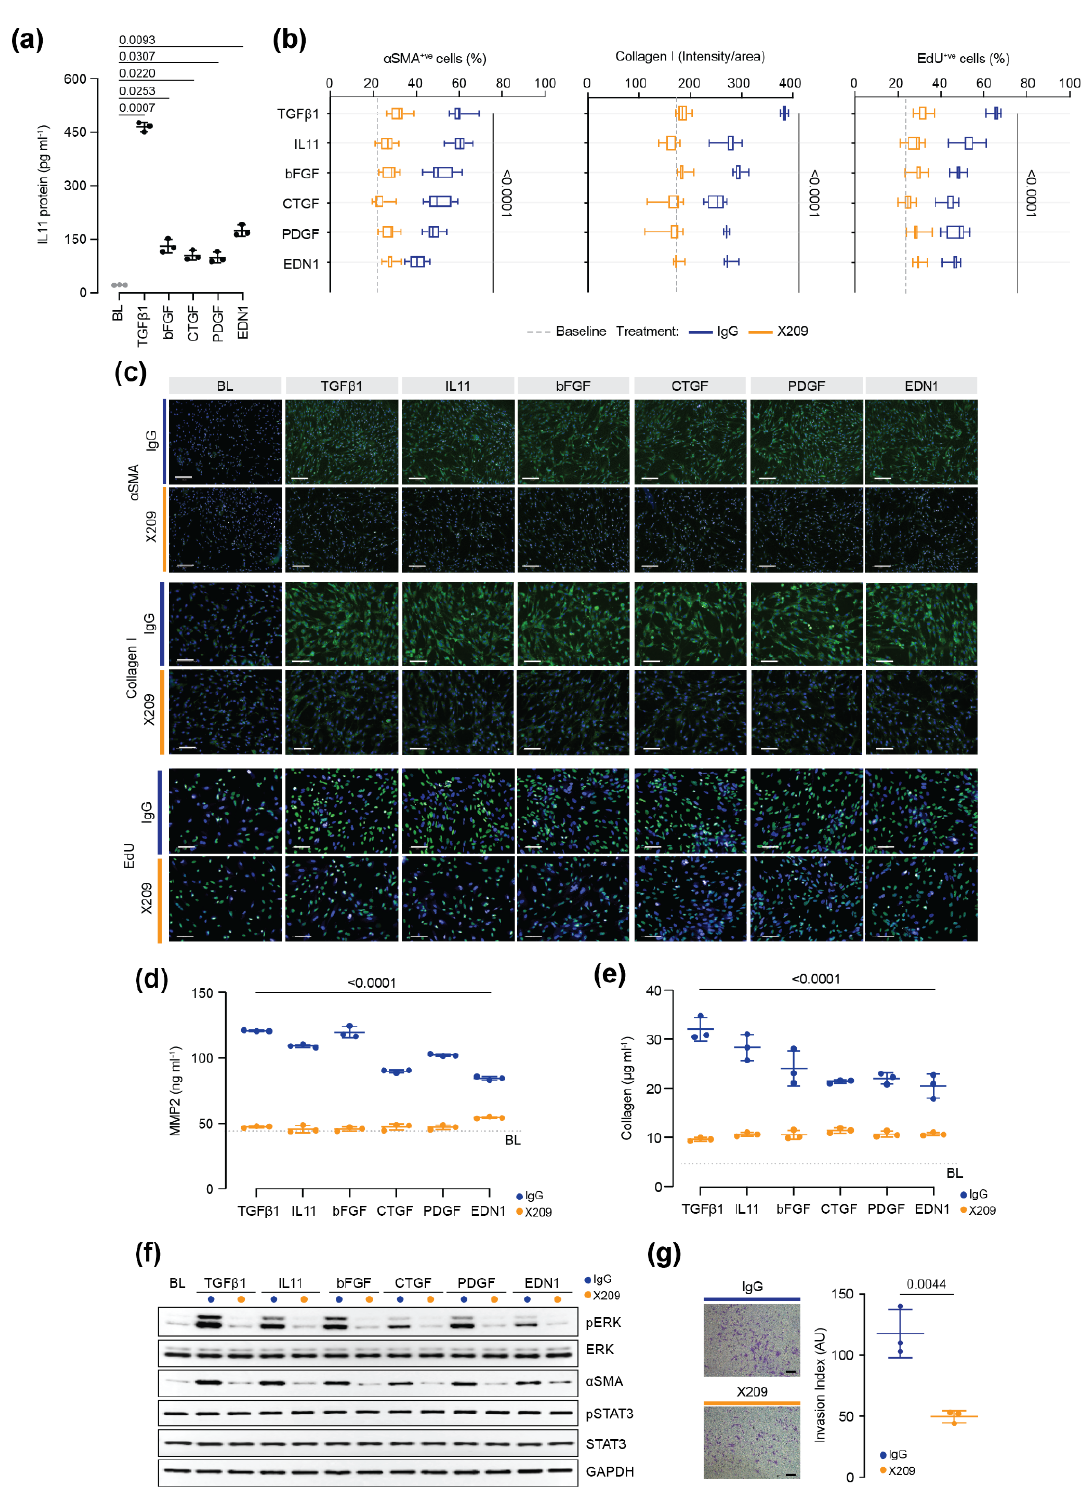
Figure 2. Autocrine IL11 signalling is important downstream of several pancreatitis factors. ( a ) ELISA of secreted IL11 from PSCs after 24 h treatment with recombinant human TGFβ1 (5 ng /mL), bFGF (10 ng/mL), CTGF (10 ng/mL), PDGF (200 ng/mL), EDN1 (250 ng/mL). ( b , c ) Representative immunofluorescence images and quantification of αSMA +ve cells and collagen I immunostaining of PSCs treated with IgG or the neutralizing IL11RA antibody (X209, 24 h) and profibrotic cytokines listed in panel ( a ). Cells were counterstained with DAPI. Scale bars: 200 µm. ( d ) ELISA of secreted MMP2 and ( e ) Sirius Red quantification of secreted collagen in the culture supernatant of PSCs treated as depicted in panel ( c ). ( f ) Western blot analysis of phosphorylated and total ERK and STAT3, and αSMA in lysates of PSCs treated with various profibrotic stimuli with either IgG or X209 (2 µg/mL, 24 h). ( g ) Matrigel invasion capacity of PSCs treated with IgG or X209 (2 µg/mL) and PDGF (20 ng/mL). Scale bars: 150 µm. AU: arbitrary unit. Data are represented as mean ±SD in ( a , d , e , g ) or as median and whiskers extending from minimum to maximum values in panel ( b ). p